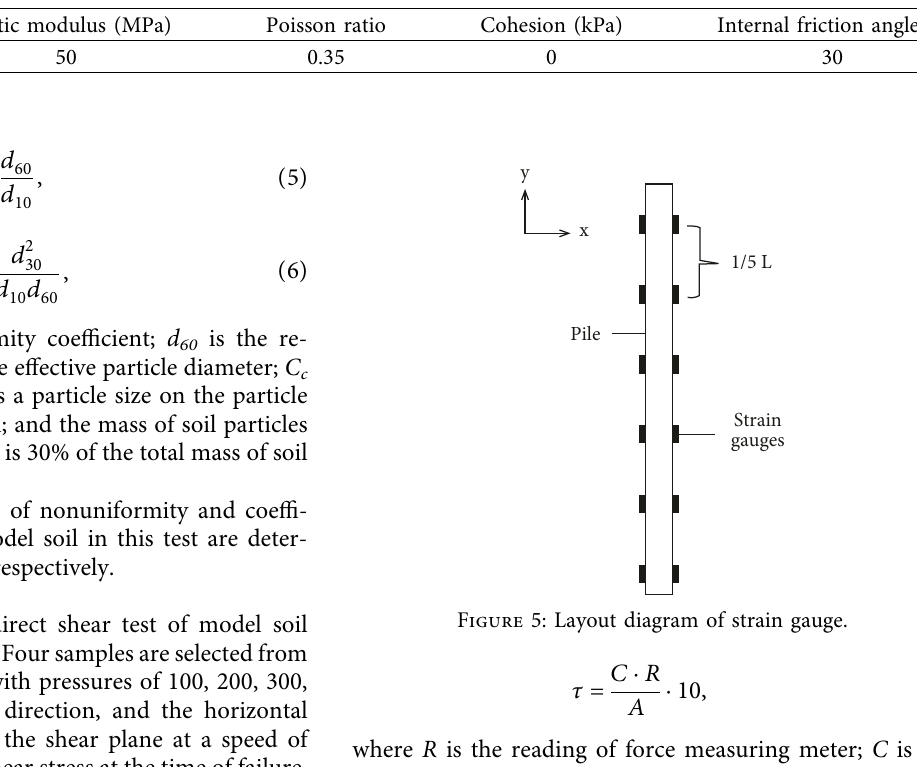
Figure 4: Direct shear apparatus. Table 4: Parameters of soil.